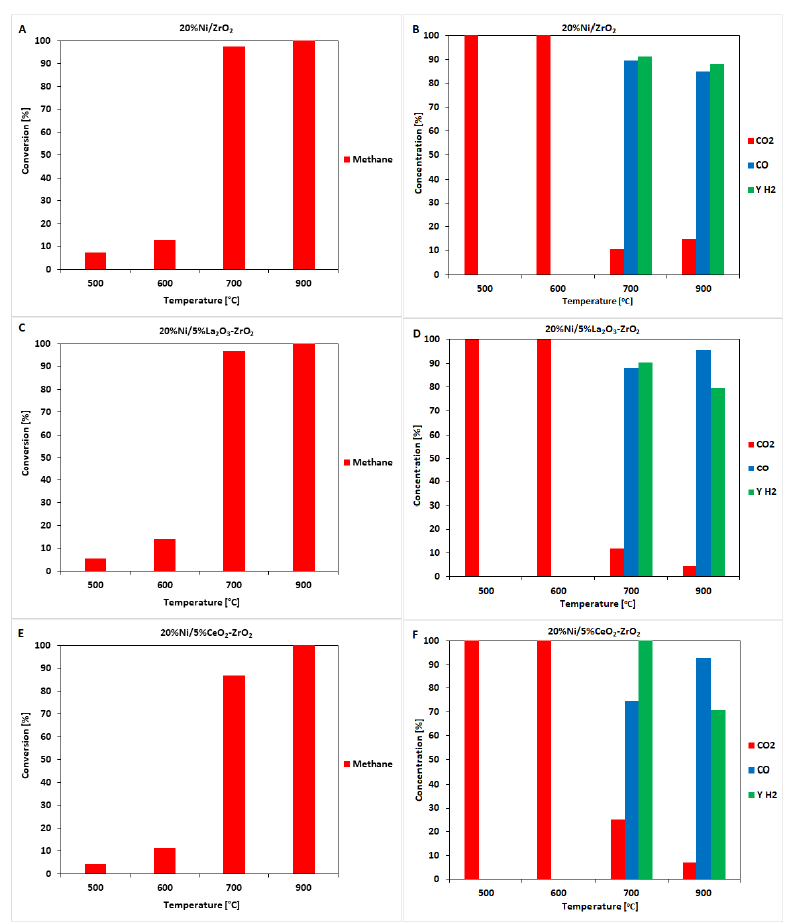
Figure 2. Catalytic activity results obtained in the oxy-steam reforming of methane expressed as methane conversion, and the selectivity of the CO and CO 2 formed during the process and hydrogen yield. ( A , B )—20%Ni / ZrO 2 , ( C , D )—20%Ni / 5%La 2 O 3 -ZrO 2 , ( E , F )—20%Ni / 5%CeO 2 -ZrO 2 . Furthermore, the 20%Ni/ZrO 2 catalyst exhibited the highest hydrogen formation (64.6%), and